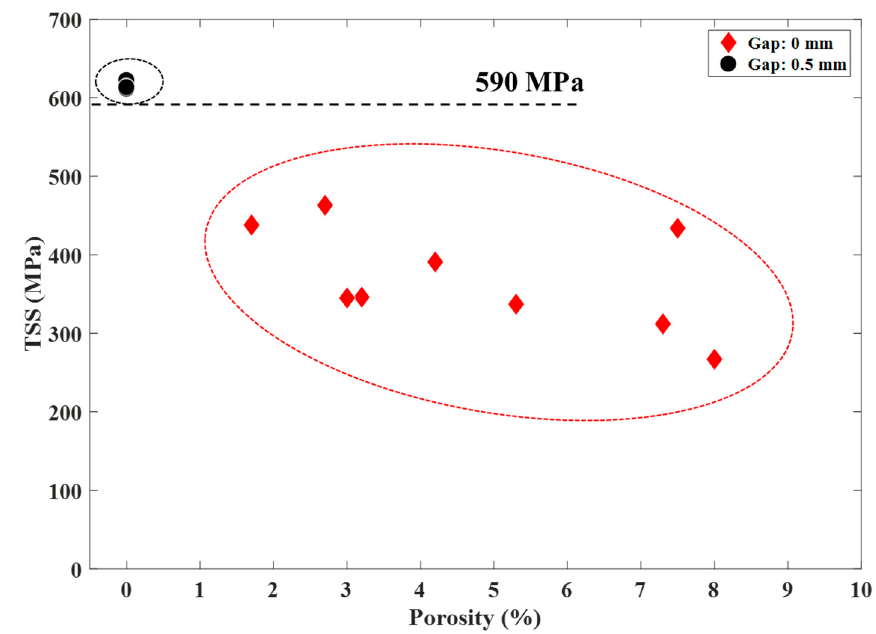
Figure 9. Correlation between the porosity and the TSS.